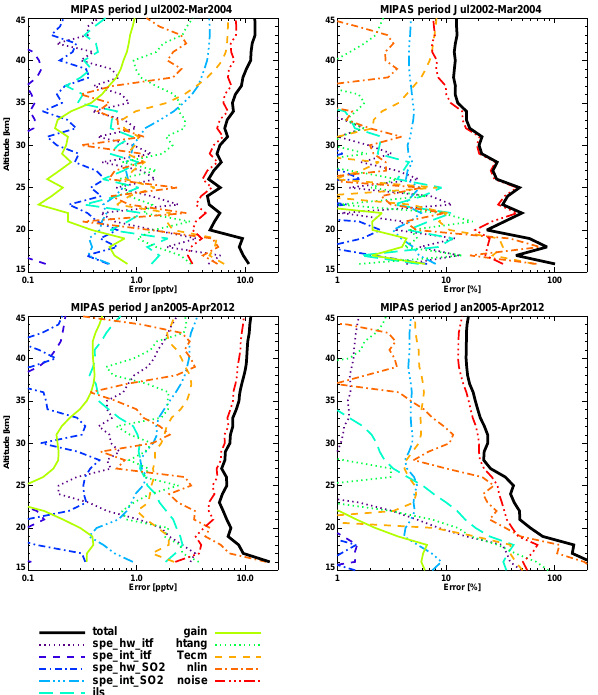
Fig. 3. Error estimation of the retrieval for one month during P1 and one month during P2. Considered error sources are the uncertainty of the foreign-broadened half-width and line intensity of interfering species (spe_hw_itf, spe_int_itf), the knowledge of these parame- ters for SO 2 (spe_hw_SO2, spe_int_SO2), the uncertainties of the instrumental line shape and gain calibration (ils, gain), the errors in the assumed tangent altitudes and temperatures (htang, Tecm), the error due to the applied technique of retrievals from averaged spec- tra (nlin) and the spectral noise of the instrument (noise). The total error has been determined by quadratic combination of the single error